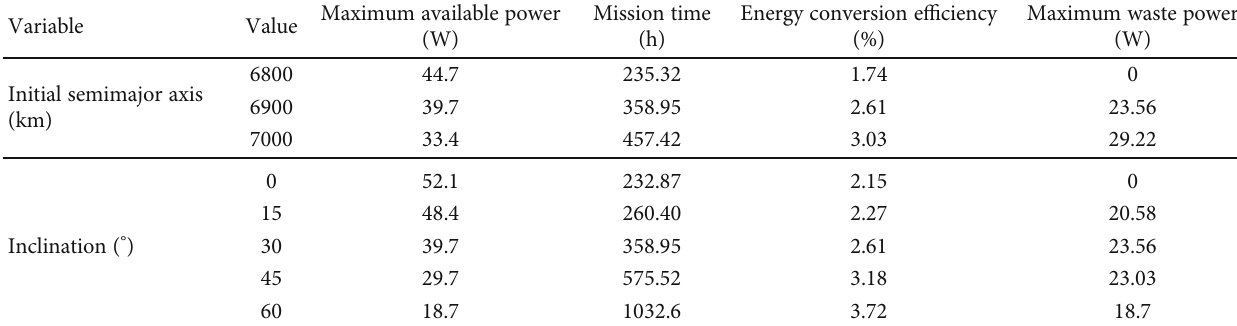
Table 5: Battery performance for di ff erent orbit